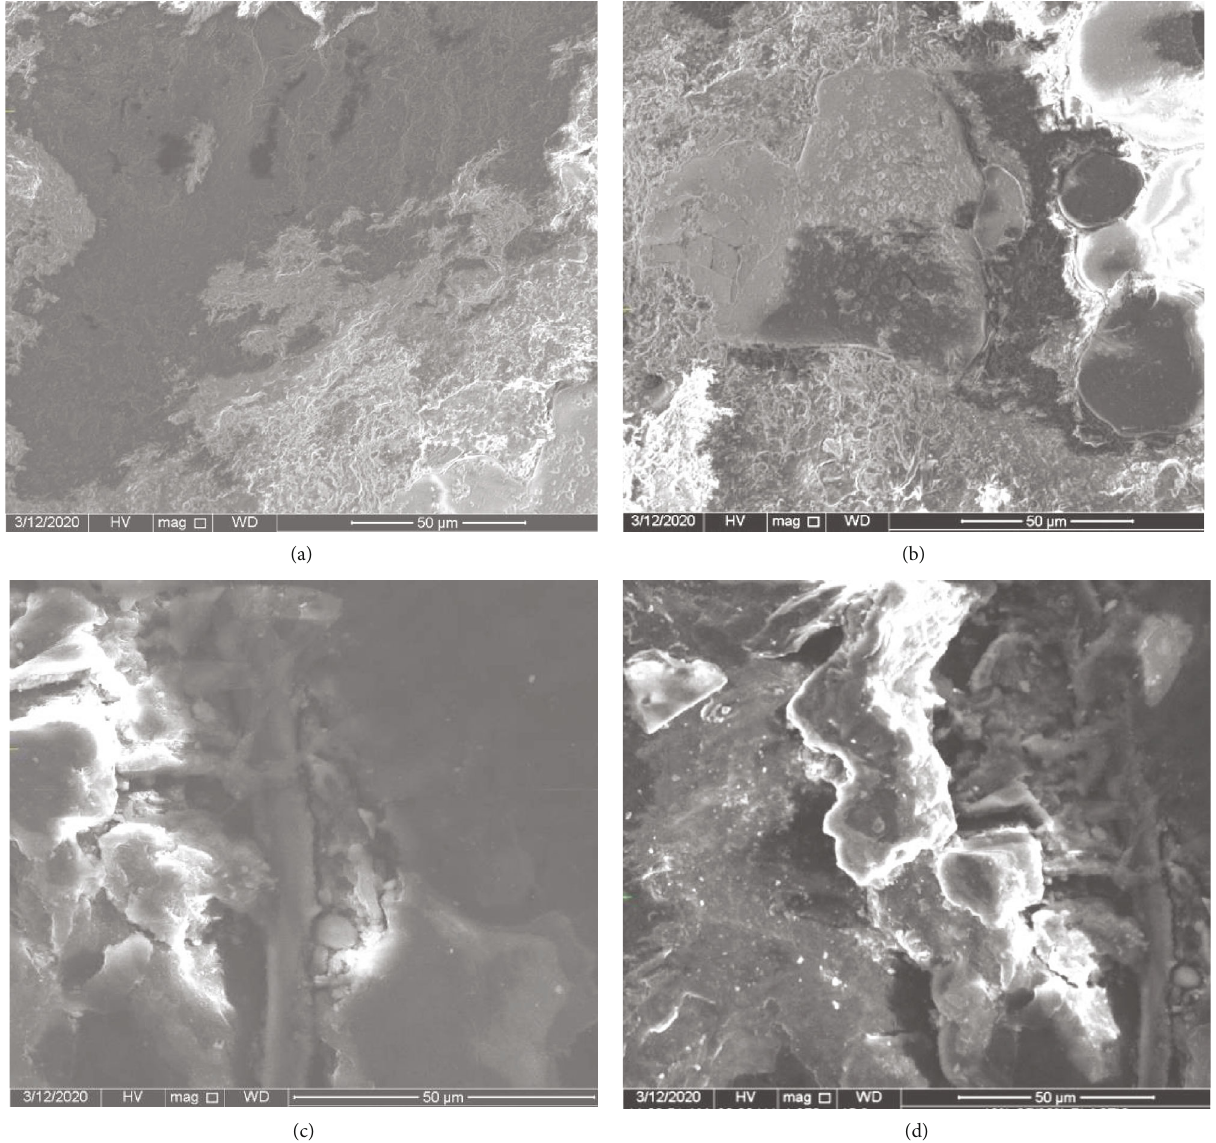
Figure 5: SEM images of composite (a) 0%, (b) 5%, (c) 10%, and (d) 15% fi ber